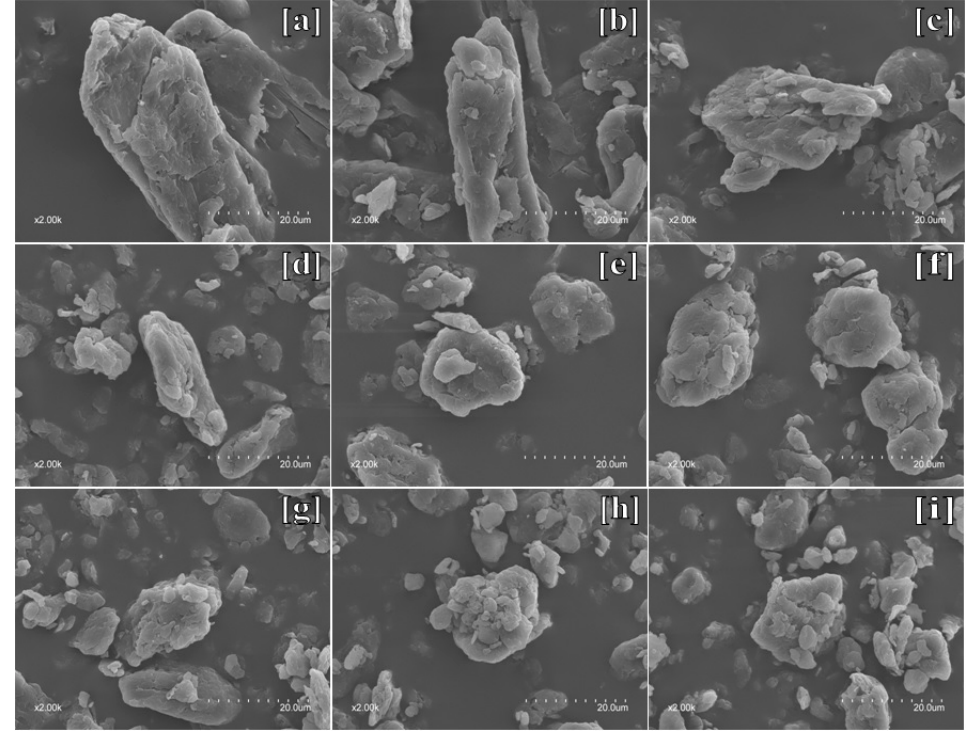
Figure 1. The morphology of the unmilled MCC sample and MCC samples with ball milling time of 1, 2, 3, 4, 6, 8, 12, 16 h, respectively, at 2000-fold magnification ( a – i ).